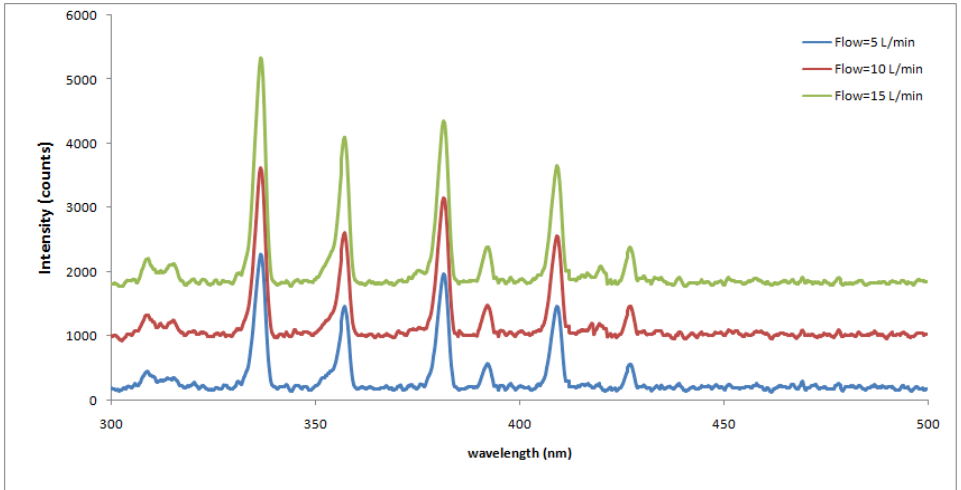
Fig. 2: Optical emission spectra (OES) in the range (300 - 500) nm as a region of wavelength for the proposed by Ar plasma